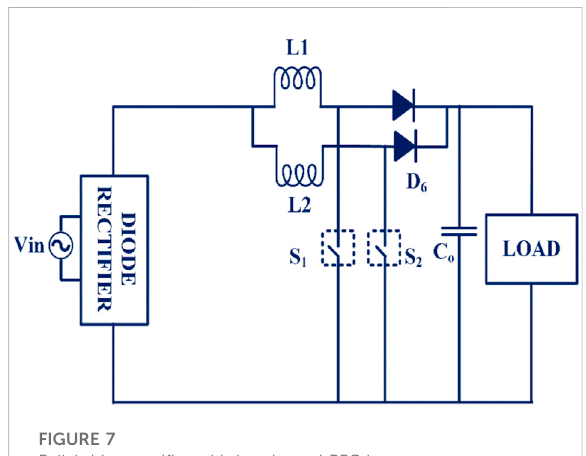
FIGURE 7 Full-bridge recti fi er with interleaved PFC boost